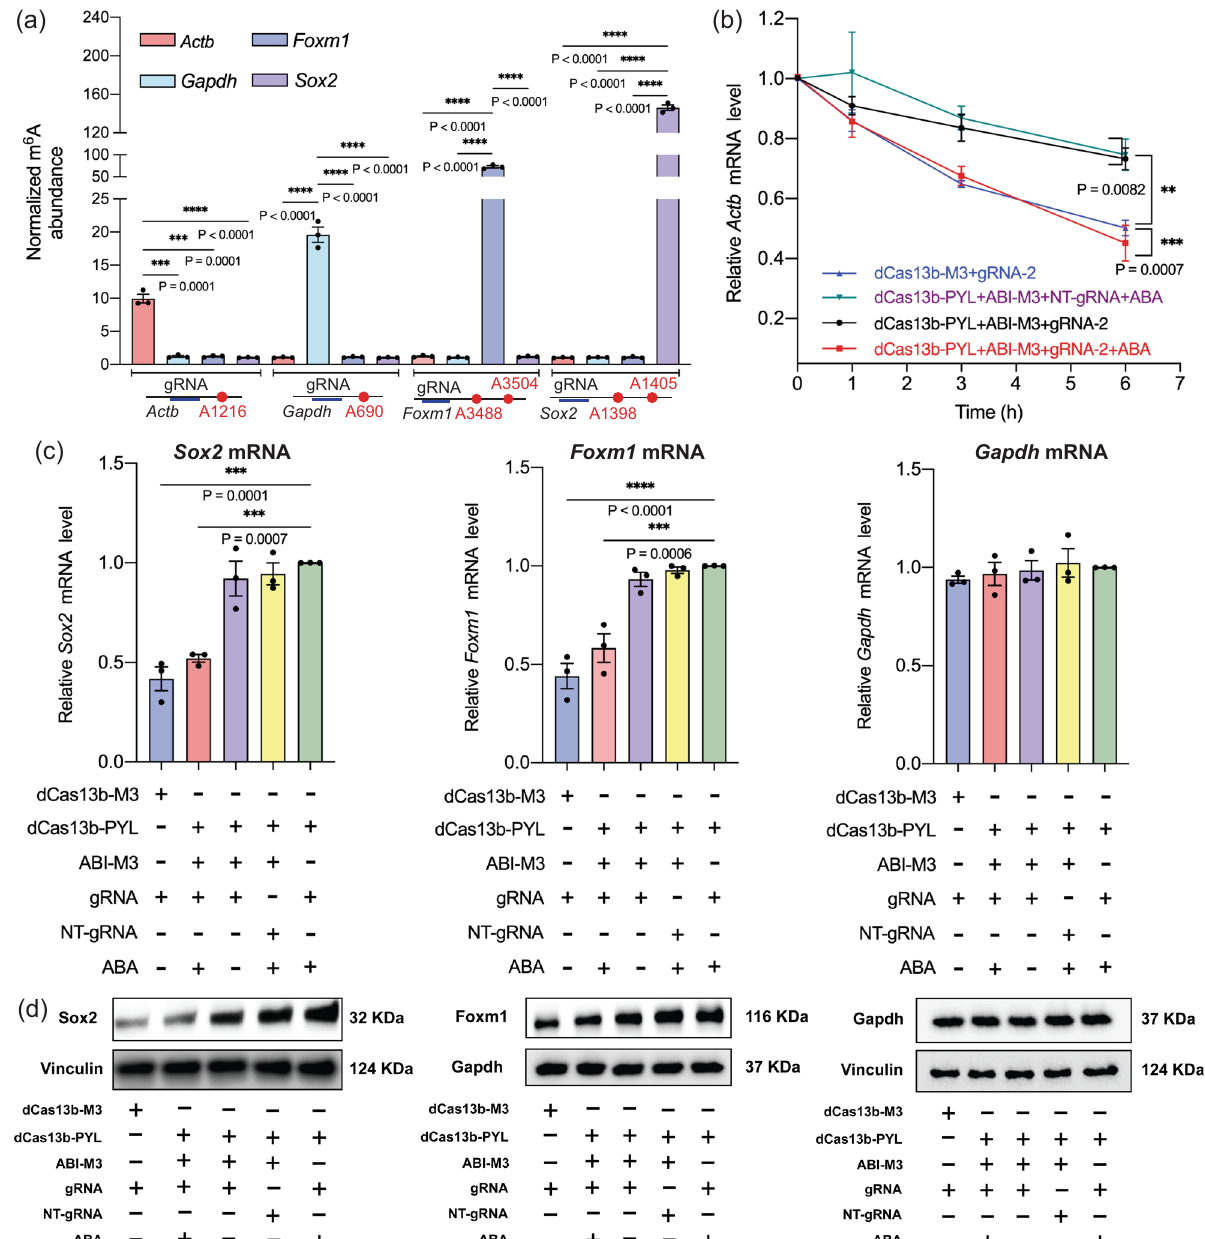
Fig. 3 ABA-induced m 6 A writing on different RNAs and the biological effects on RNA stability and translation of installed m 6 A. a The relative m 6 A level changes at different mRNA sites when using different mRNA-speci fi c gRNAs for editing. b The relative abundance of Actb mRNAs in HEK293 cells at different time points after actinomycin D treatment under different m 6 A writing conditions. Gapdh was used as the internal control gene. c The relative abundance of Sox2 , Foxm1 , and Gapdh mRNAs in HEK293 cells under different m 6 A writing conditions. The mRNA levels were quanti fi ed after 6-h actinomycin D treatment. P values are shown in charts determined by one-sample t and Wilcoxon test. d Western blotting of Sox2 , Foxm1 , and Gapdh protein levels (top panel) under different m 6 A writing conditions. Endogenous Vinculin or Gapdh were used as the internal control (lower panel). All results of groups in a – c with different treatments were normalized to the group of dCas13b-PYL with gRNA-2 and ABA treatment. Values and error bars re fl ect the mean, s.e.m. of three independent biological replicates. P values shown in the charts are determined by one-way ANOVA. Three independent trials were performed for d and representative images were shown. Source data are provided as a Source Data fi